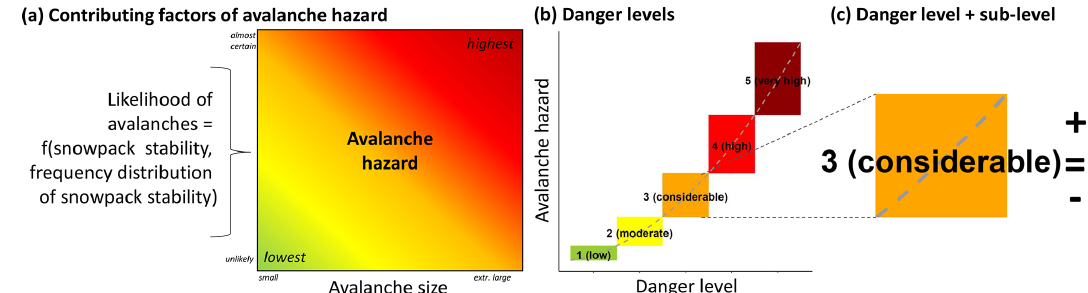
Figure 1. (a) Avalanche hazard chart. The contributing factors of avalanche hazard are snowpack stability, the frequency distribution of snowpack stability, and avalanche size (Techel et al., 2020a; EAWS, 2021). In the CMAH, these are termed the likelihood of triggering and the destructive avalanche size (Statham et al., 2018a). (b) Avalanche hazard, continuous in nature, is summarized using five ordinal danger levels. (c) In Switzerland, three ordinal sub-levels are assigned to danger levels indicating whether the hazard is high ( + or plus ), in the middle ( = or neutral ), or low ( − or minus ) within a respective level. The gradient of the color transition (panel a ) and the shape of the curve and the size of the boxes in panel (b) are for illustration purpose